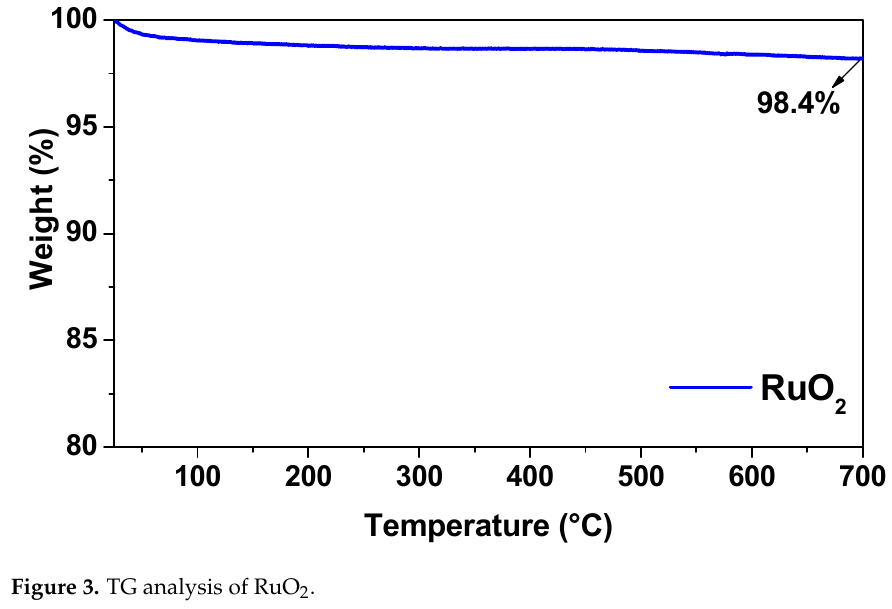
Figure 3. TG analysis of RuO 2 .